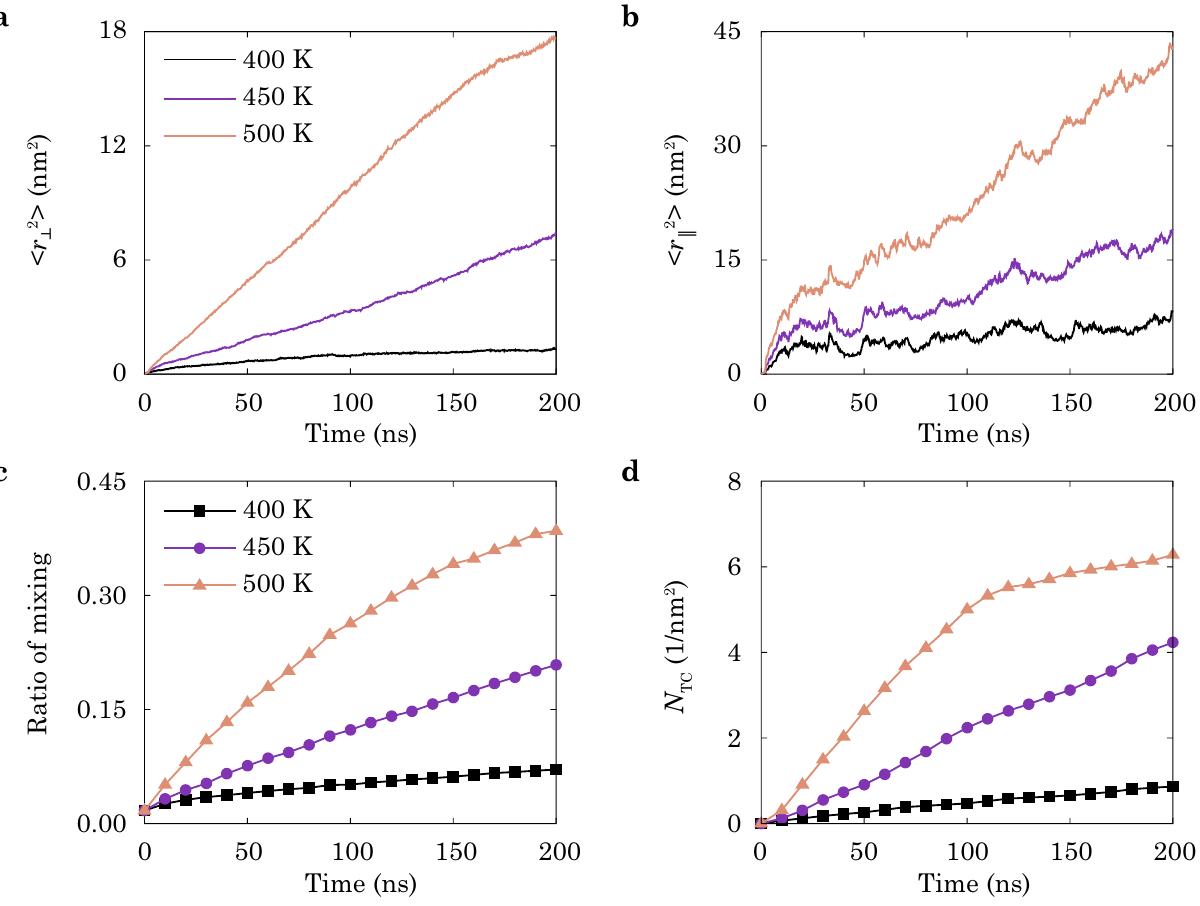
Figure 3. CGMD simulation results of the microstructural indicators of the PE/PP heat-fusion processes at different fusion temperature, T = 400, 450, 500 K. ( a , b ) Mean-square distances (MSDs) of polymer chains 2 (cid:29) is the component parallel to the interface, and � r 2 across the interface, where (cid:31) r (cid:30) the interface. ( c ) Ratio of mixing and ( d ) areal density of TCs, N TC , are calculated against the time of fusion.